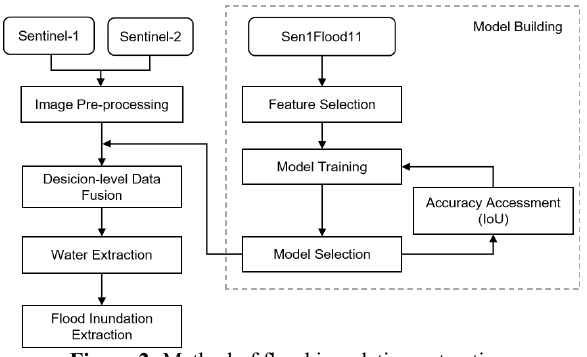
Figure 2 . Method of flood inundation extraction.